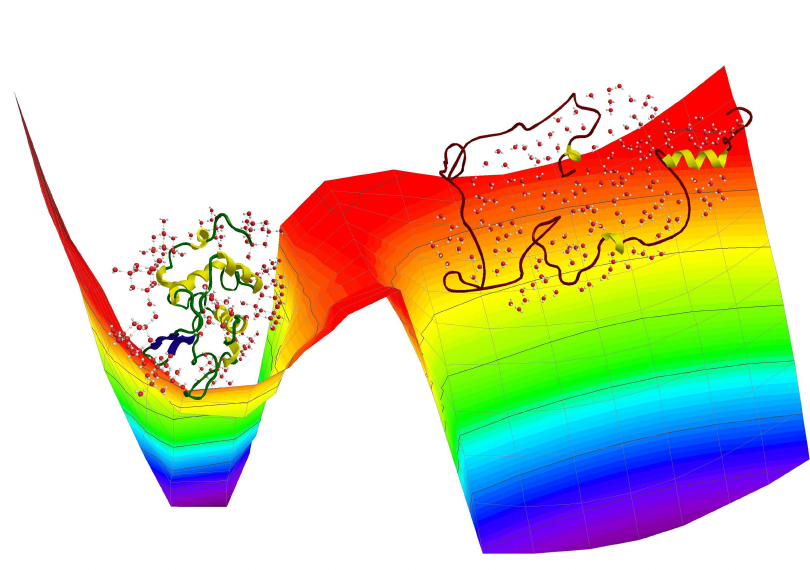
Figure 2. Three-dimensional simplified representation of the energy landscape for hydrated lysozyme, with only two wells of different height and width. At lower temperature (left well), the protein is in its native state and water molecules can develop a soft tetrahedral network surrounding the protein surface. At higher temperature (right well), the protein is an almost linear chain of amino acids and water molecules are essentially